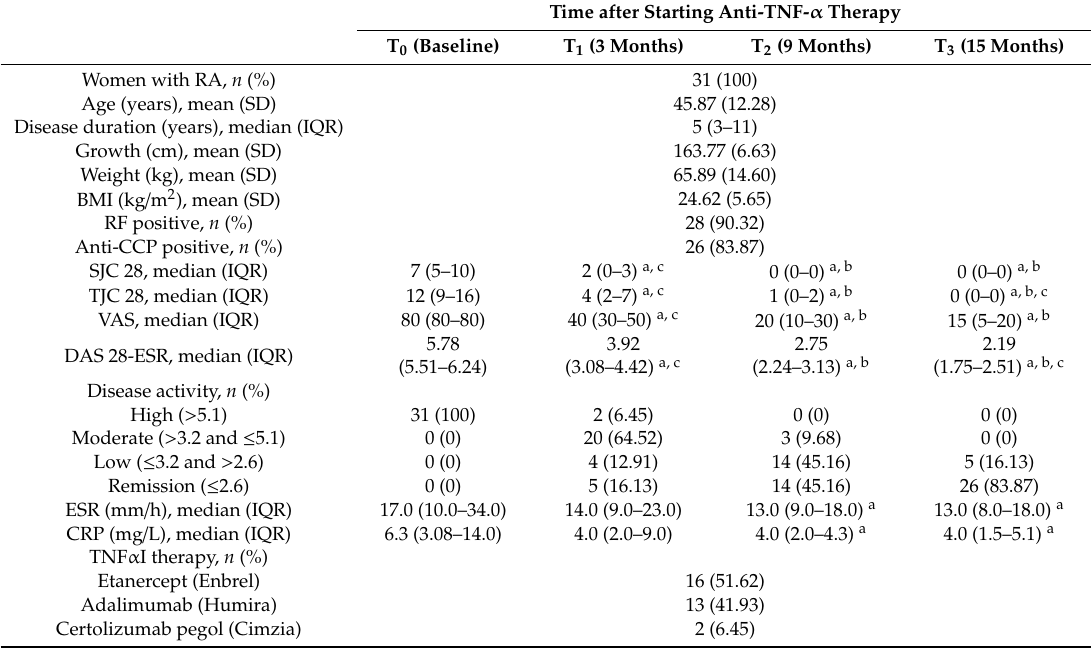
Table 2. Time-course changes in biochemical, clinical and functional measures during 15-month anti-TNF- α